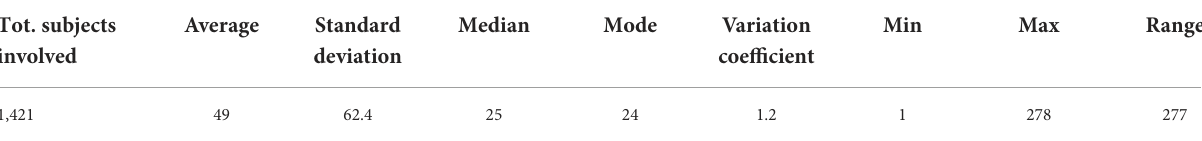
TABLE 6 Descriptive sample